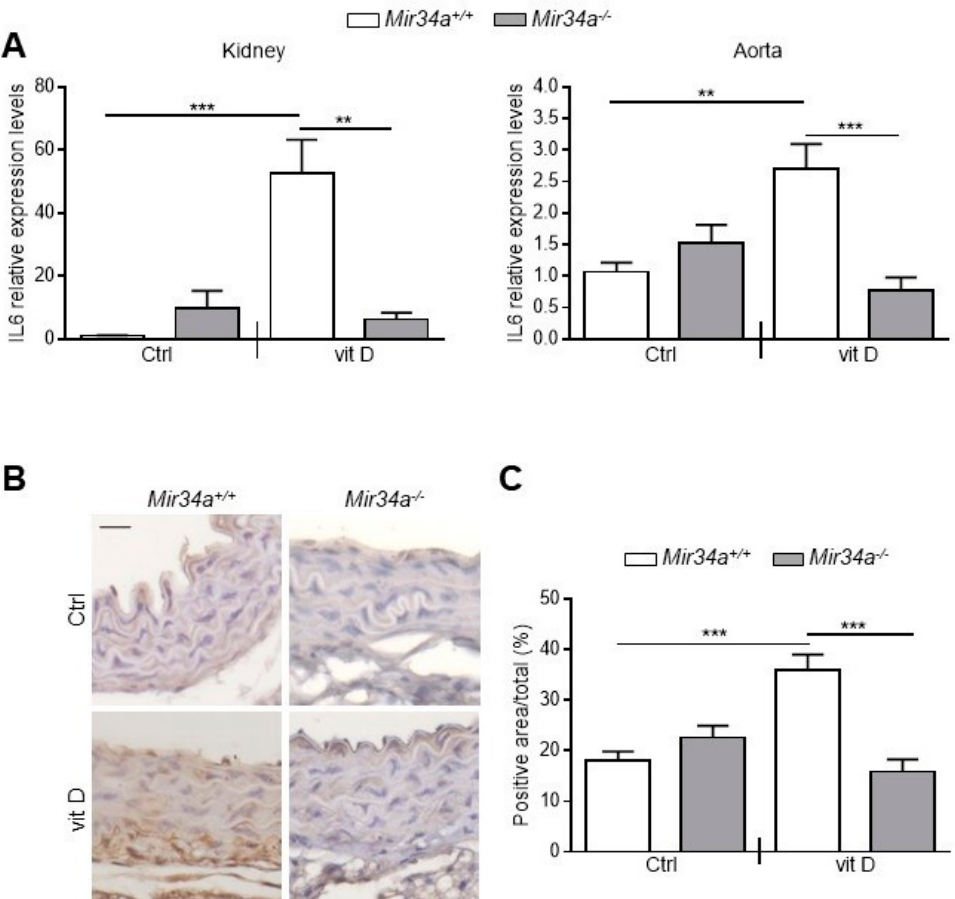
Figure 5. IL6 expression in Mir34a +/+ and Mir34a − / − mice early after vitamin D treatment. Twelve-week-old Mir34a +/+ and Mir34a − / − mice were treated subcutaneously with either vitamin D (vit D) or a mock solution (Ctrl) for three consecutive days and sacrificed 3 days after the first injection (Day 3). ( A ) IL6 expression was analyzed by qRT-PCR and normalized to HPRT levels in the kidney and abdominal aorta. Values are mean ± SD. ** p < 0.01, *** p < 0.001; 1-way ANOVA with a Bonferroni post hoc test; n = 6, 5, 6–7 and 4–5. ( B ) Representative images of thoracic aorta sections stained for IL6 expression with a specific antibody. Bar = 20 µ m. ( C ) Bars show quantification of the percentage of IL6 positive area to the total thoracic aortic area relative to ( B ). Values are mean ± SD; ***, p < 0.001; 1-way ANOVA followed by Bonferroni’s multiple comparison test; n = 4, 4, 4 and 3.